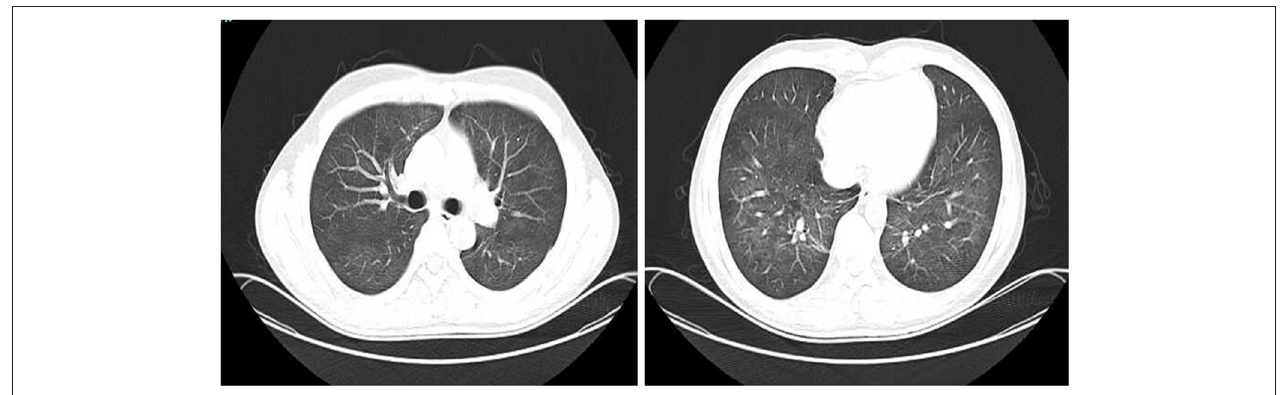
FIGURE 1 | CT of the lung revealed multifocal bilateral ground-glass opacities on